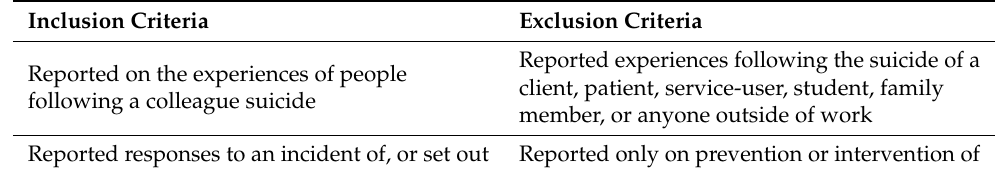
Table 1. Inclusion and exclusion criteria.